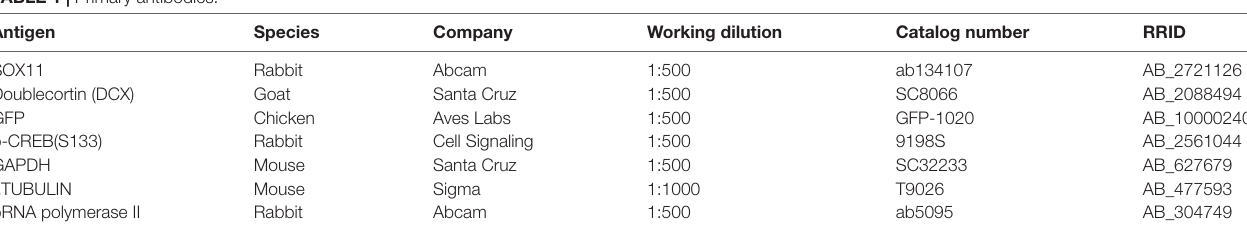
TABLE 1 | Primary antibodies.